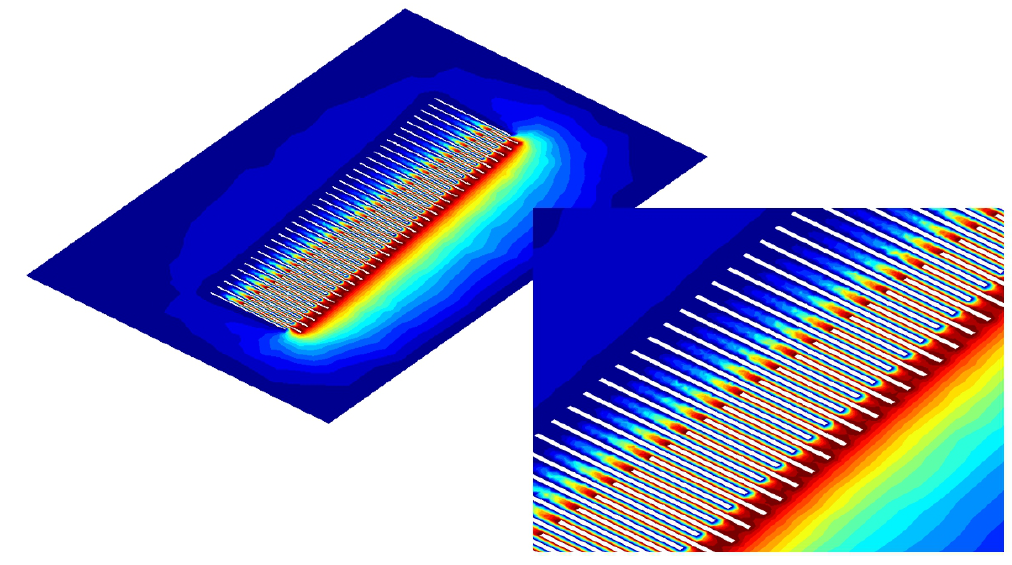
Figure 4. Potential ϕ distribution in the comb. The shuttle is set to ϕ = 1 (red) and stator is set to ϕ = 0